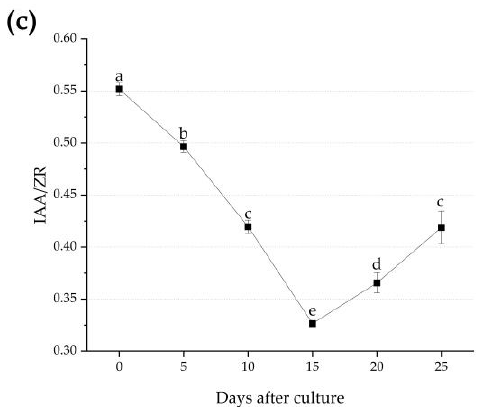
Figure 5. Changes in ratios of IAA/ABA, ABA/GA 3 , and IAA/ZR during rooting of B. buttiana ‘Miss Manila’. ( a ) IAA/ABA ratio. ( b ) ABA/GA 3 ratio. ( c ) IAA/ZR ratio. Data present the means of three replicates ± SE. Letters on the top of each point show p < 0.05; the same letters show the non-significant difference, while different letters show a significant difference between different days after culture.